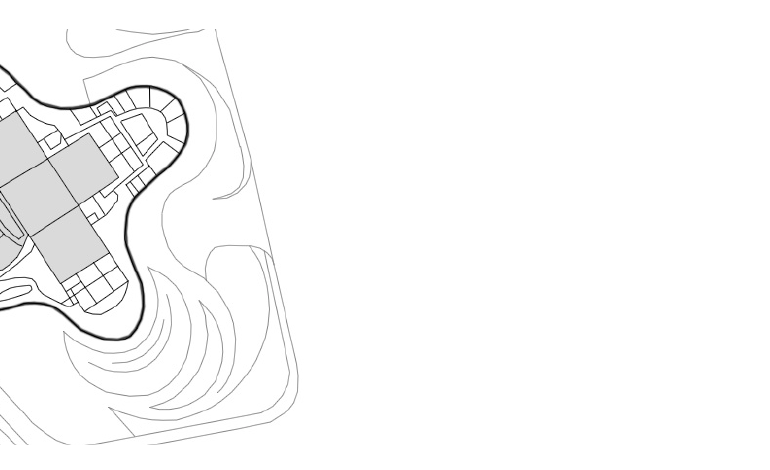
Figure 19. Hunan Grand Theatre in the Changsha Meixihu International Contemporary Art Mu-